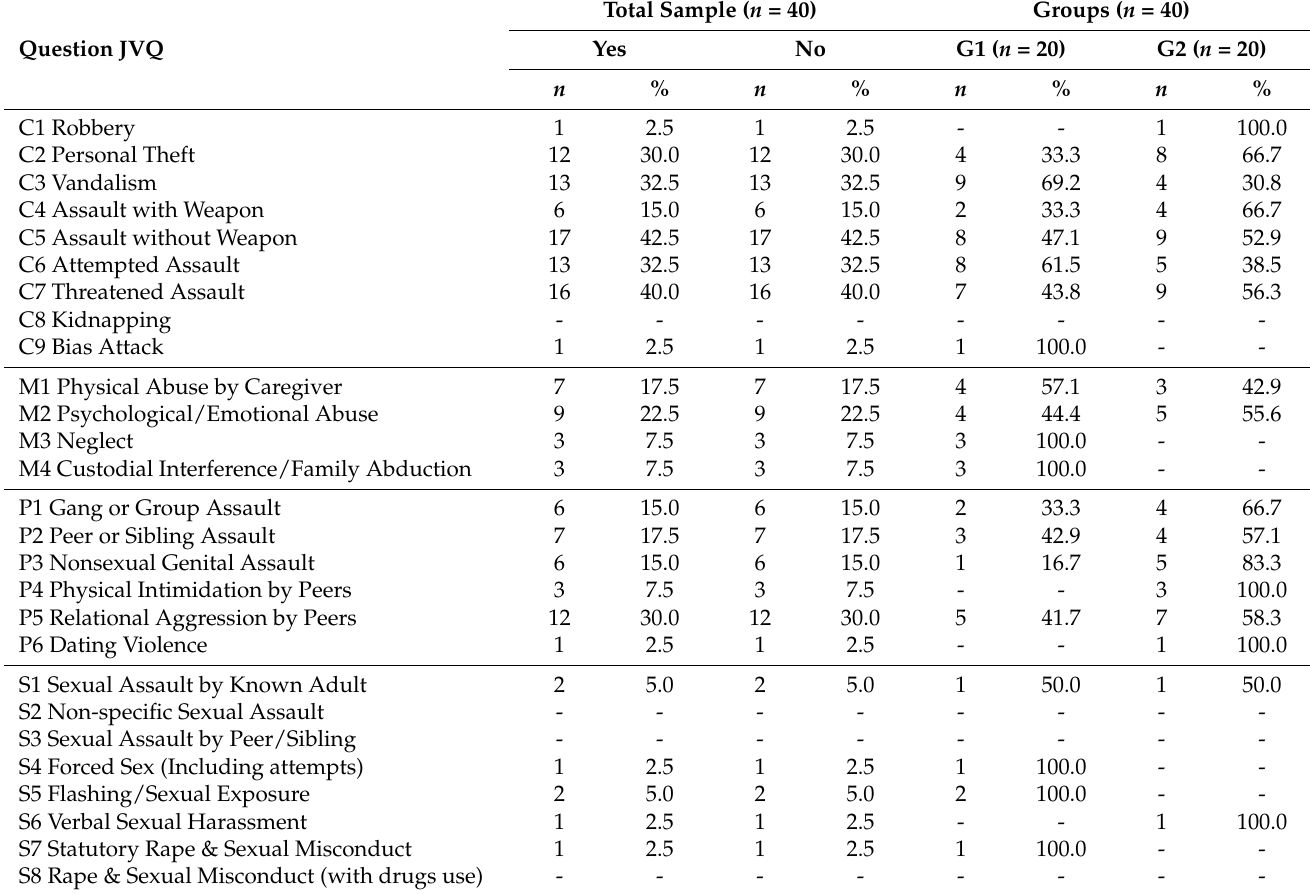
Table 2. Frequency of responses by total sample and groups of young